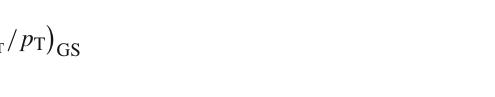
in the lower part of Fig. 10a. The quantity (cid:8)σ is